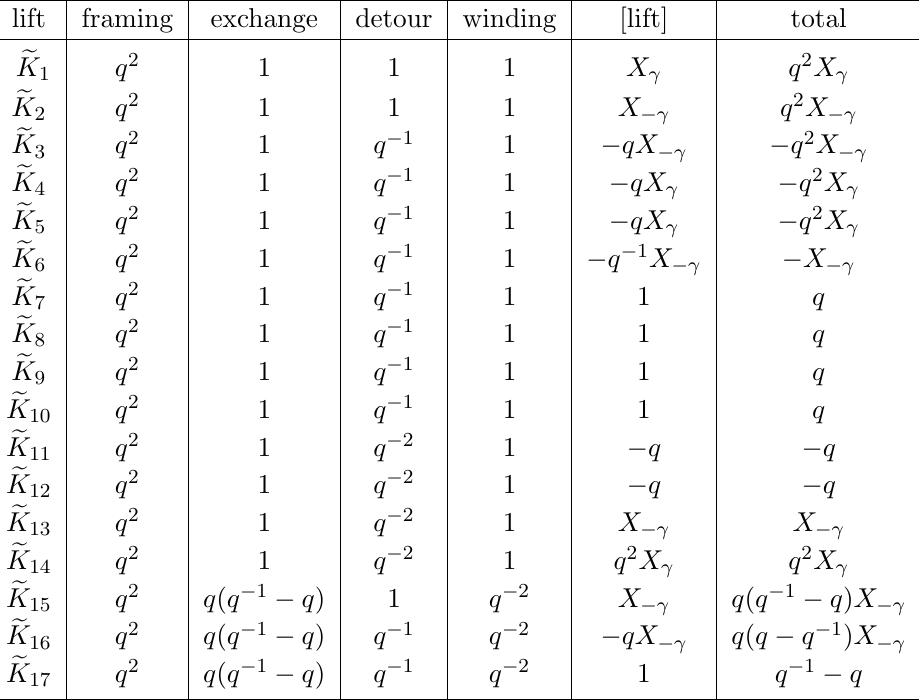
Table 4 . Summary for the seventeen lifts of the unknot K in (cid:12)gure